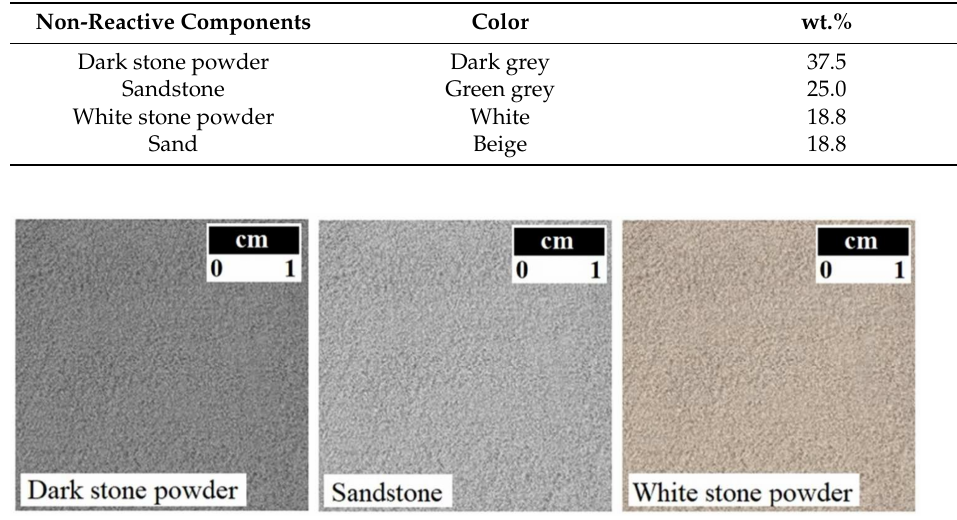
Figure 2. Various luminosities of the non-reactive powder components [colored